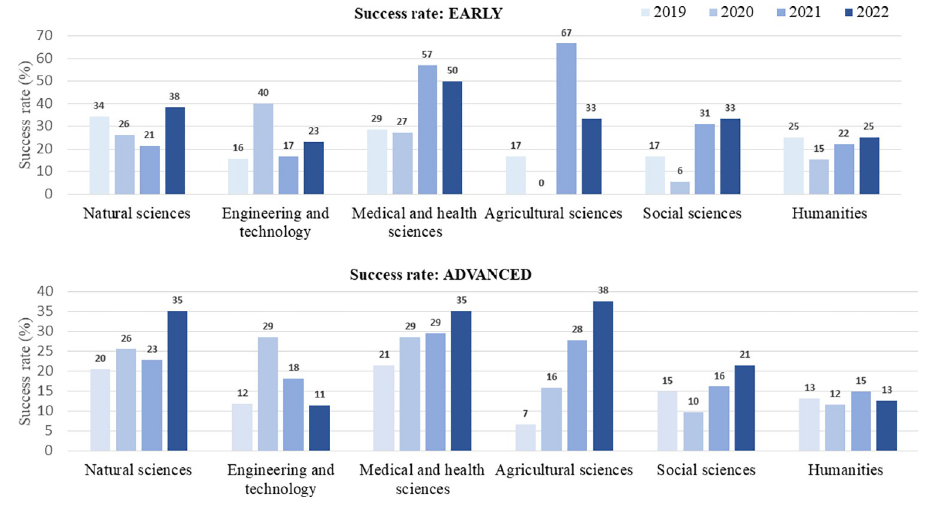
Fig 5. Annual success rates across fields and grant